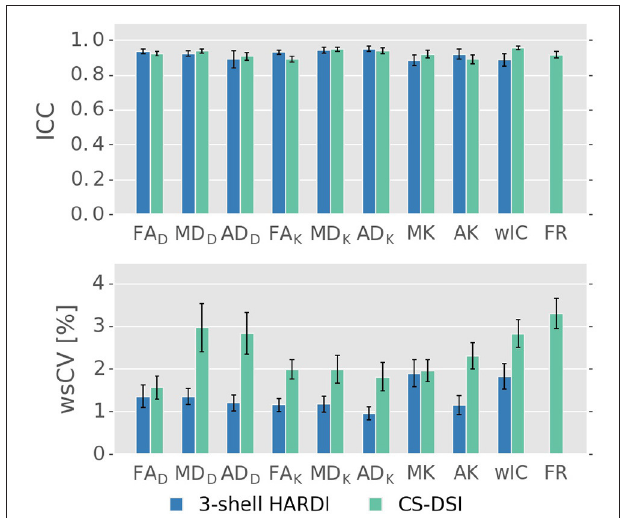
FIGURE 8 | Parameter specific ICC and wsCV averaged over nine WM tracts for the tensor (FA D , MD D , AD D ), kurtosis (FA K , MD K , AD K , MK, AK), NODDI (wIC), and CHARMED (FR) model. The latter is only reported for CS-DSI. ICC values present similar reliability for both imaging protocols. For CS-DSI, slightly lower repeatability is indicated by higher wsCV compared to 3-shell